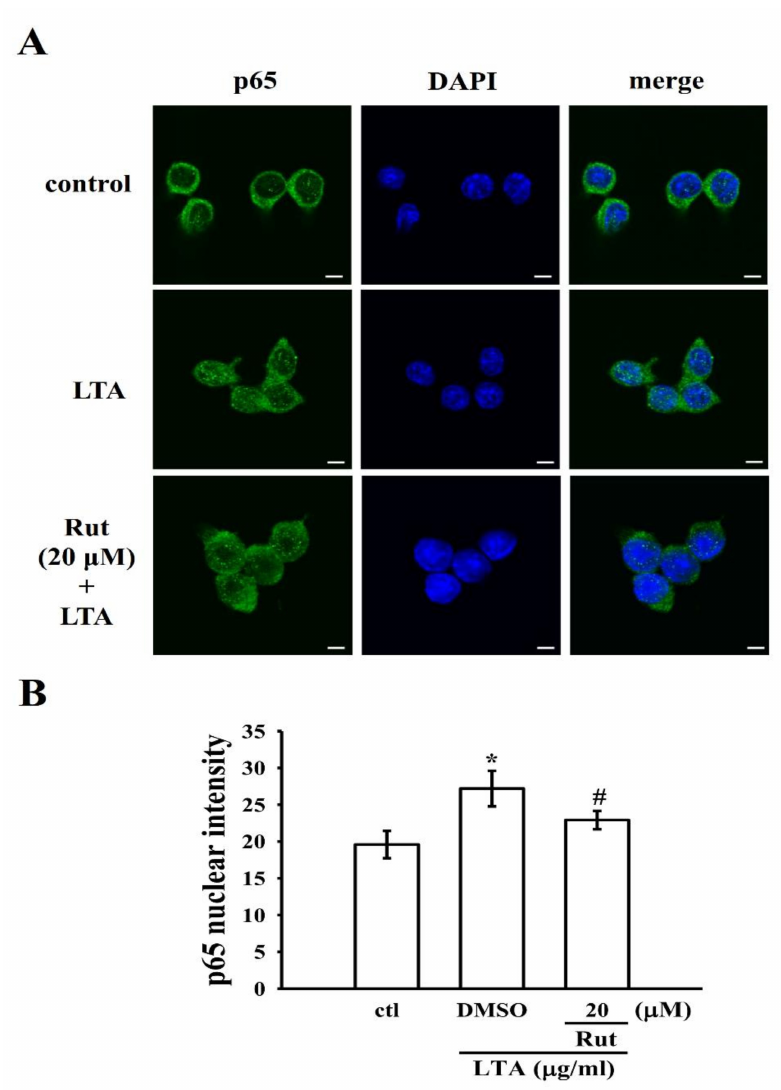
Figure 5. Effects of Rut on LTA-induced NF- κ B p65 nuclear translocation in RAW cells. Cells were treated with 0.1% DMSO, Rut (20 µ M) for 20 min, followed by LTA (10 µ g/mL) for 30 min. ( A ) The immunofluorescence staining analysis was performed with an anti-p65 antibody and FITC-conjugated anti-rabbit IgG antibody (green). 4 (cid:48) ,6-diamidino-2-phenylindole (DAPI) was used to label the nuclei (blue). The images were captured by confocal microscopy (scale bar = 5 µ m). ( B ) Data were graphed by pooling multiple images, with each individual data point corresponding to the mean fluorescence intensity of each individual cell nucleus. Data are presented as the means ± SEM ( n = 4). * p < 0.05, compared with the control group; # p < 0.05, compared with the LTA